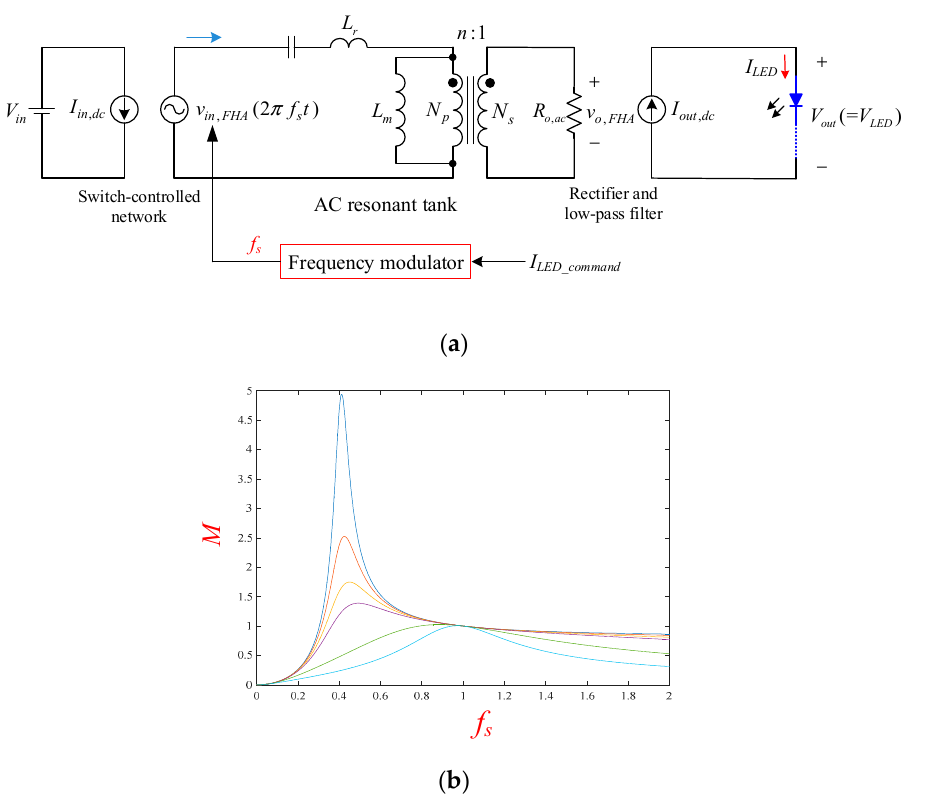
Figure 9. Two-port model of the FHA resonant circuit with: ( a ) frequency modulator; ( b ) voltage gain M versus switching frequency f s .